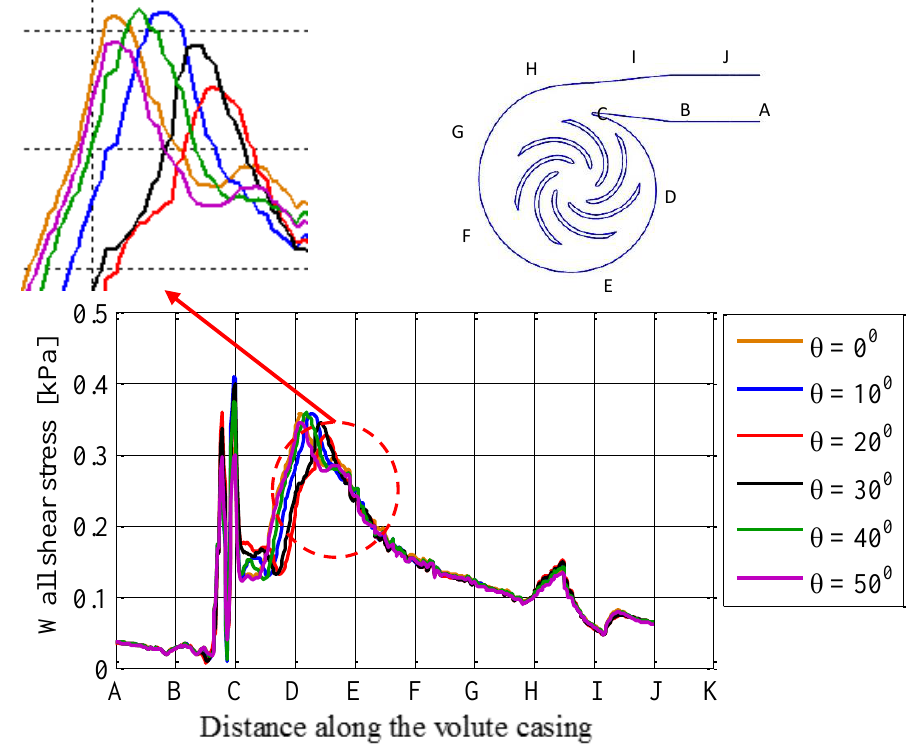
Figure 16. Variation of the wall shear stresses along the casing of the centrifugal pump at different phases of rotation.